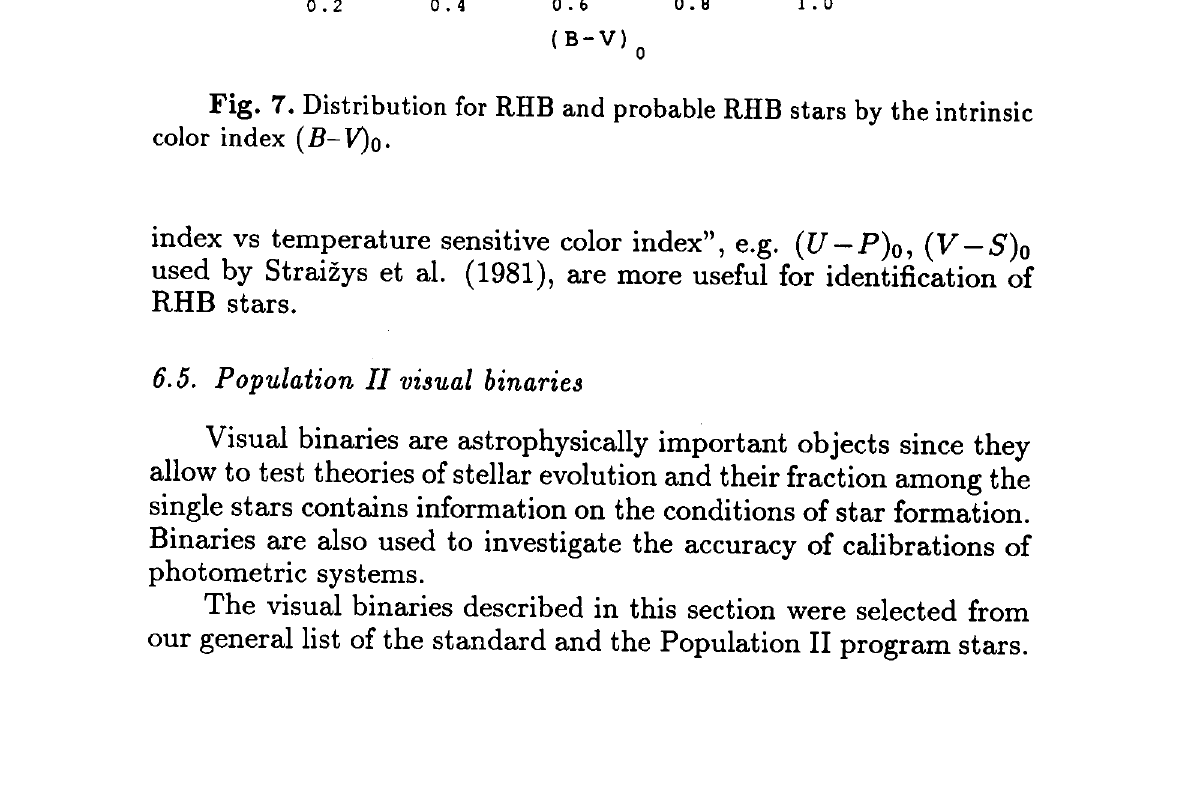
Fig. 7. Distribution for RHB and probable RHB stars by the intrinsic color index